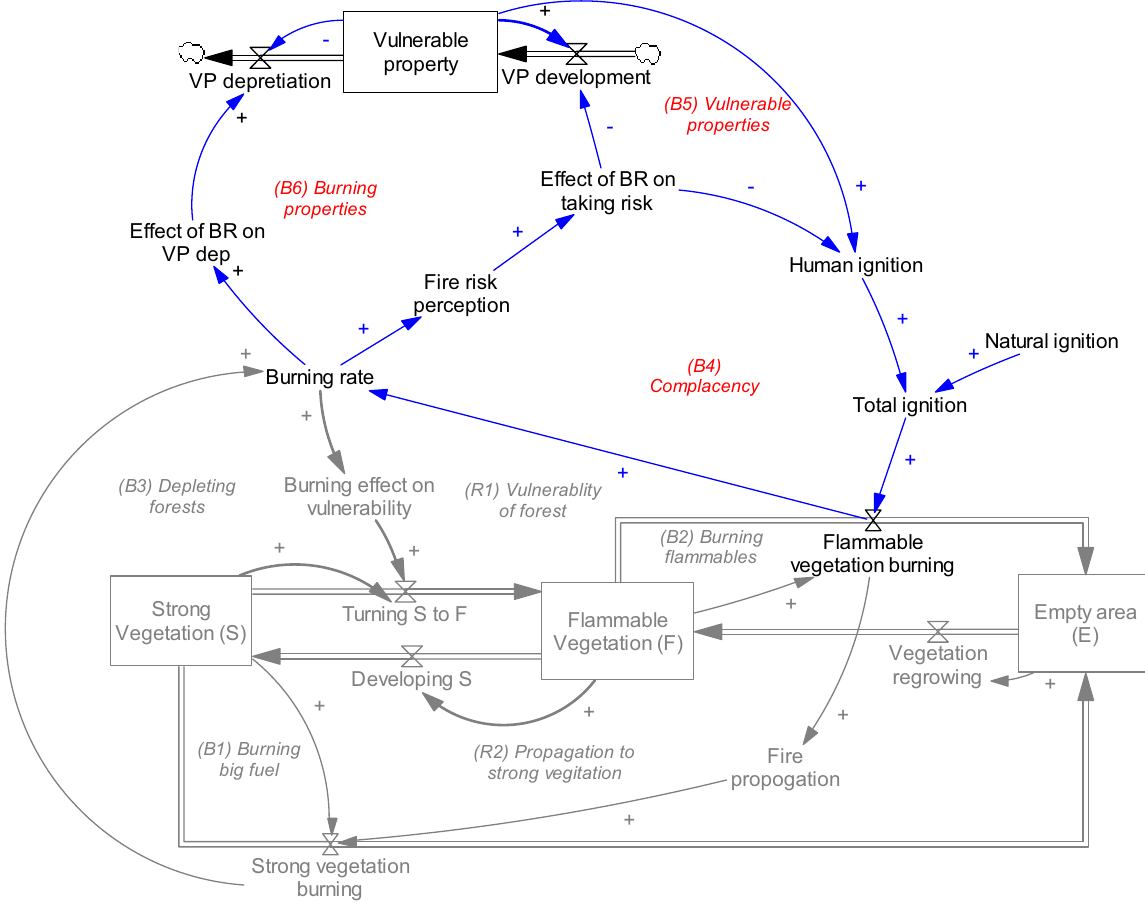
Figure 5. The human subsystem as connected to the natural subsystem (grey).